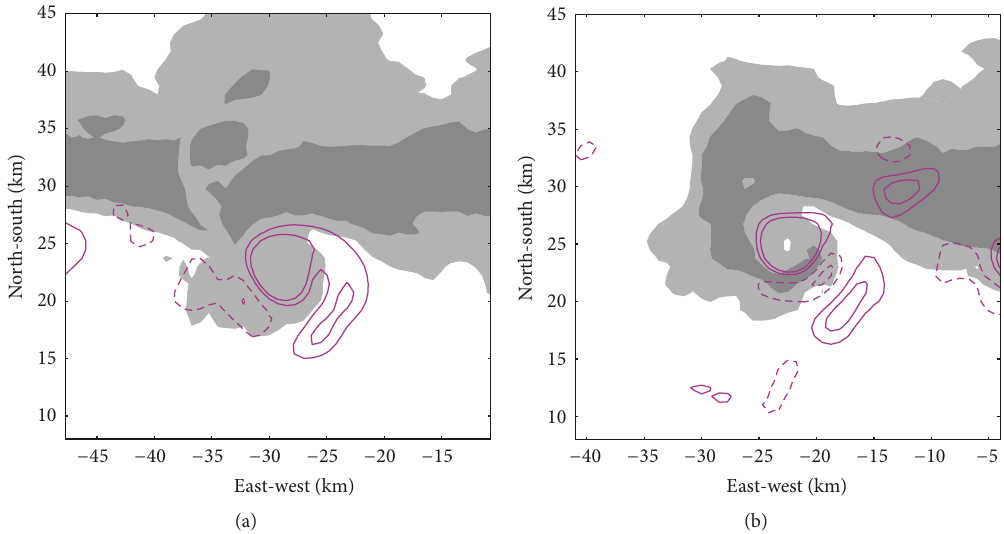
Figure16: Horizontal cross-sectionat 250 maltitudeof reflectivity at 30 (contouredin grey)and 50 dBZ(contoured indark grey)with 0–5 km average vertical vorticity contoured in magenta every 5×10 −3 s −1 at (a) 0036 UTC and (b) 0045 UTC on 30 May 2004. Solid (dashed) contours denote positive (negative) values of average vertical